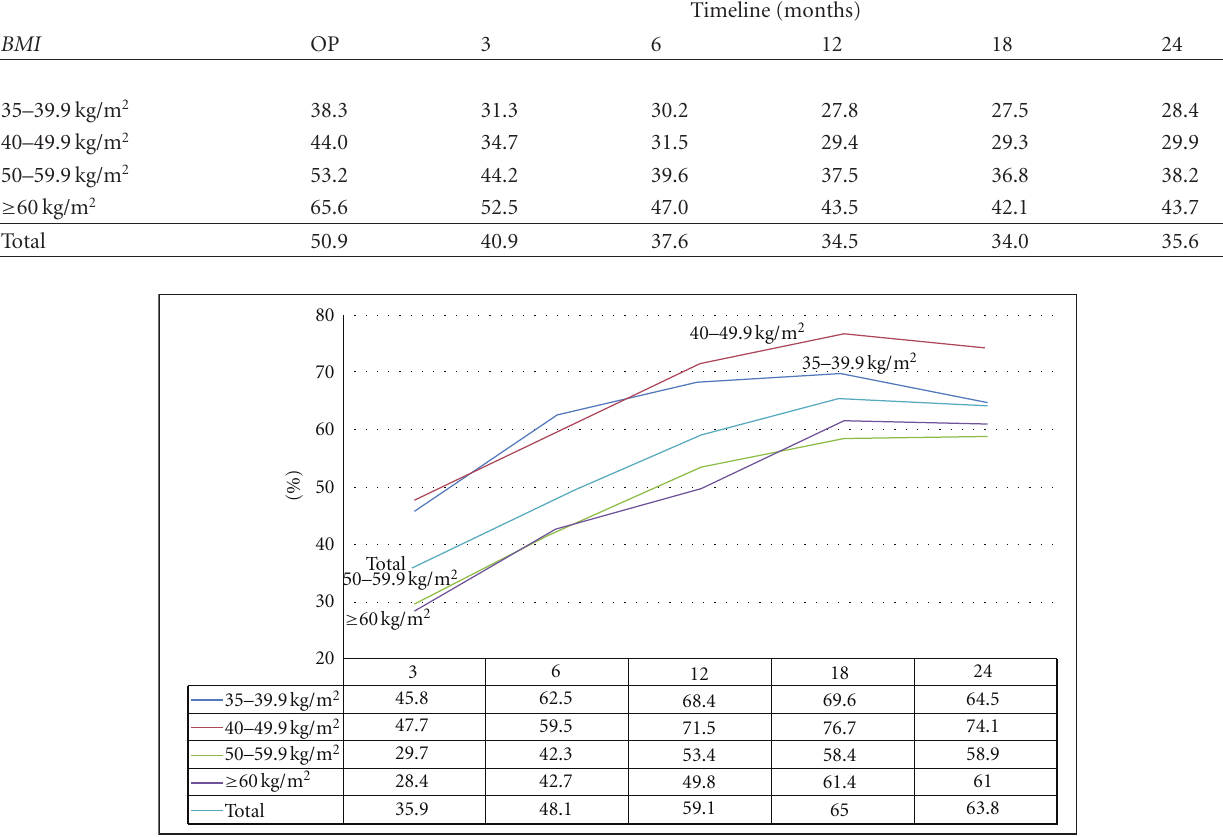
Figure 1: %EWL of all of the patients during the follow-up